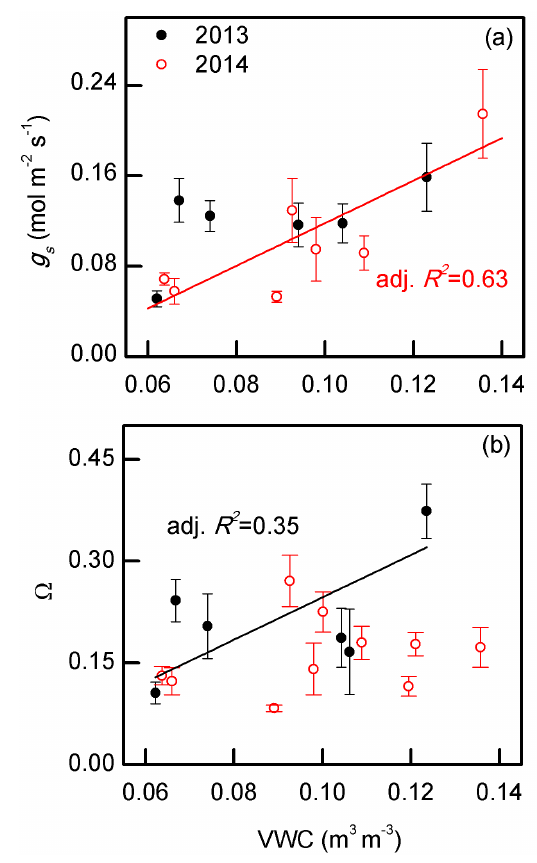
Figure 10. Relationship between volumetric soil water content (VWC) and (a) stomatal conductance ( g s ) in Artemisia ordosica , and (b) decoupling coefficient ( (cid:127) ) for 2013 and 2014. Hourly val- ues are given as binned averages based on a VWC-increment of 0.005m 3 m − 3 . Bars indicate standard error. Only statistically sig- nificant regressions (with p values < 0.05) are